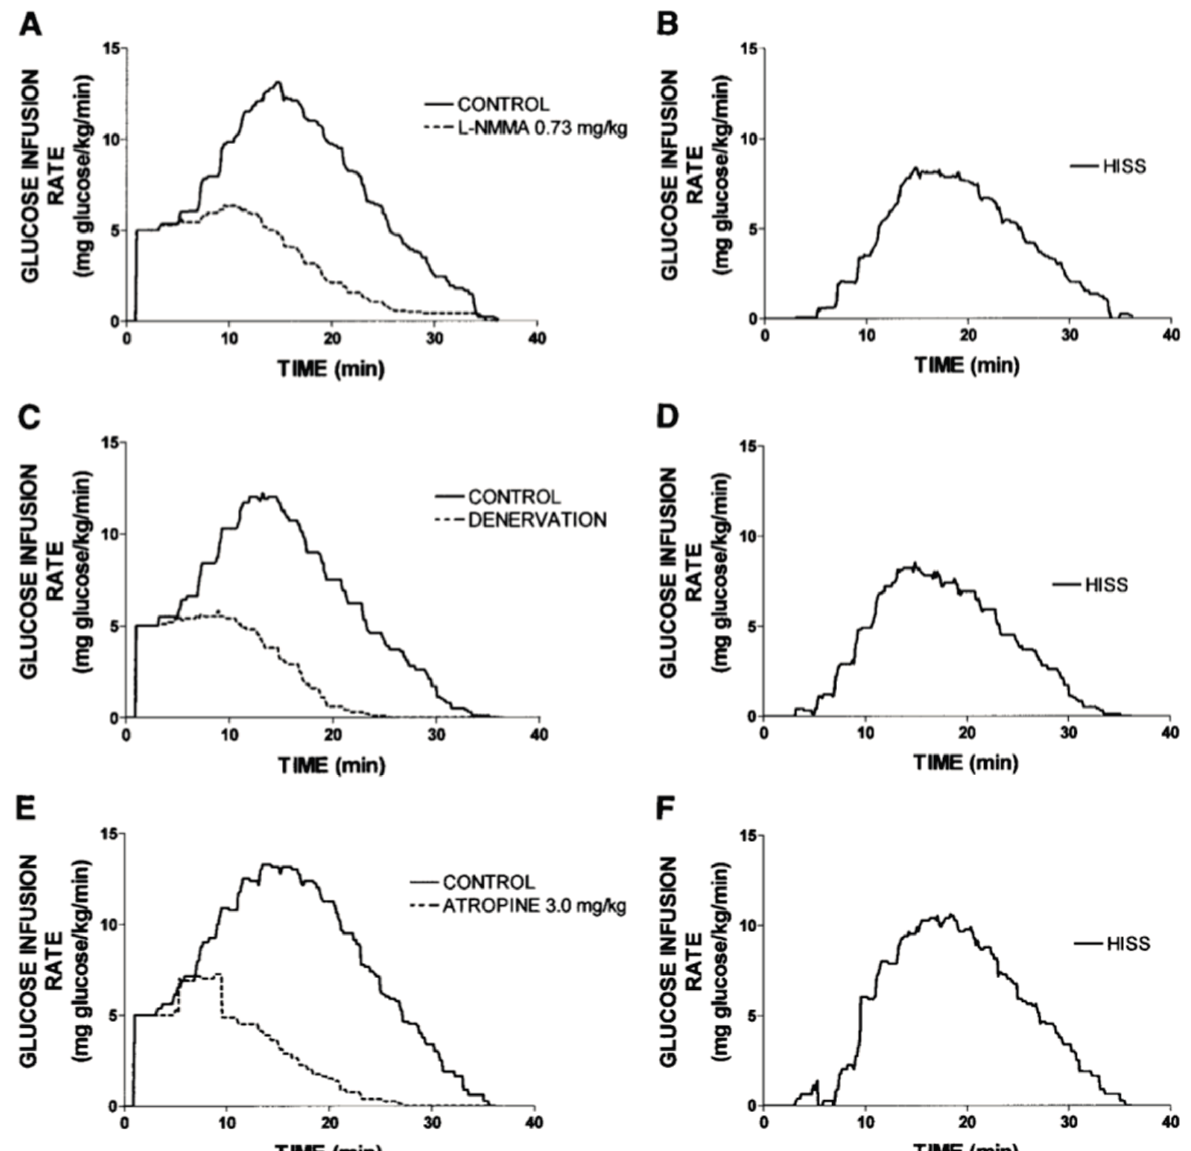
Figure 4. HISS action revealed by blocking the parasympathetic feeding signal. The dynamic insulin action using the RIST in fed, anesthetized rats shows a normal postprandial control RIST that is reduced by 56% by eliminating the hepatic parasympathetic feeding signal to block HISS release. Complete reversal of MIS results from blocking hepatic nitric oxide synthase, blocking muscarinic receptors using atropine, or physically interrupting the signal by surgical ablation. HISS action is revealed by subtracting the blocked profile from the control fed profile as shown in the right side column. HISS action commenced 3.1 minutes after onset of insulin action and continued for 9–10 minutes after completion of HISS-independent (direct) insulin action